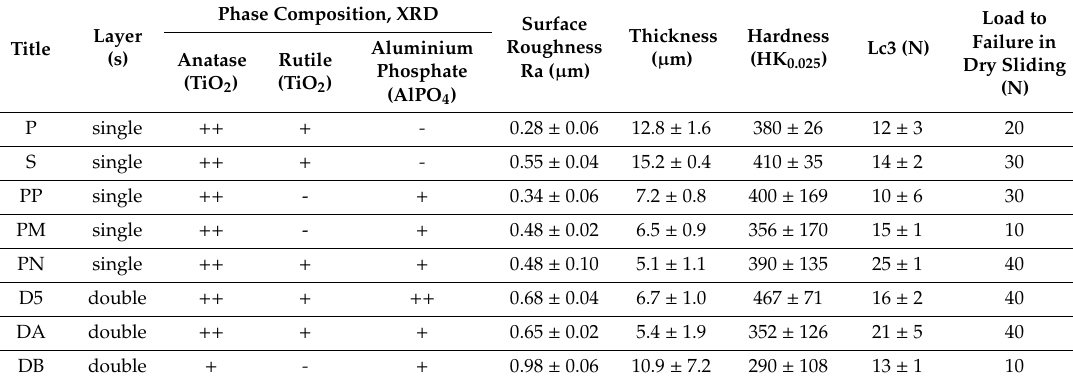
Table 2. Main features of the investigated PEO